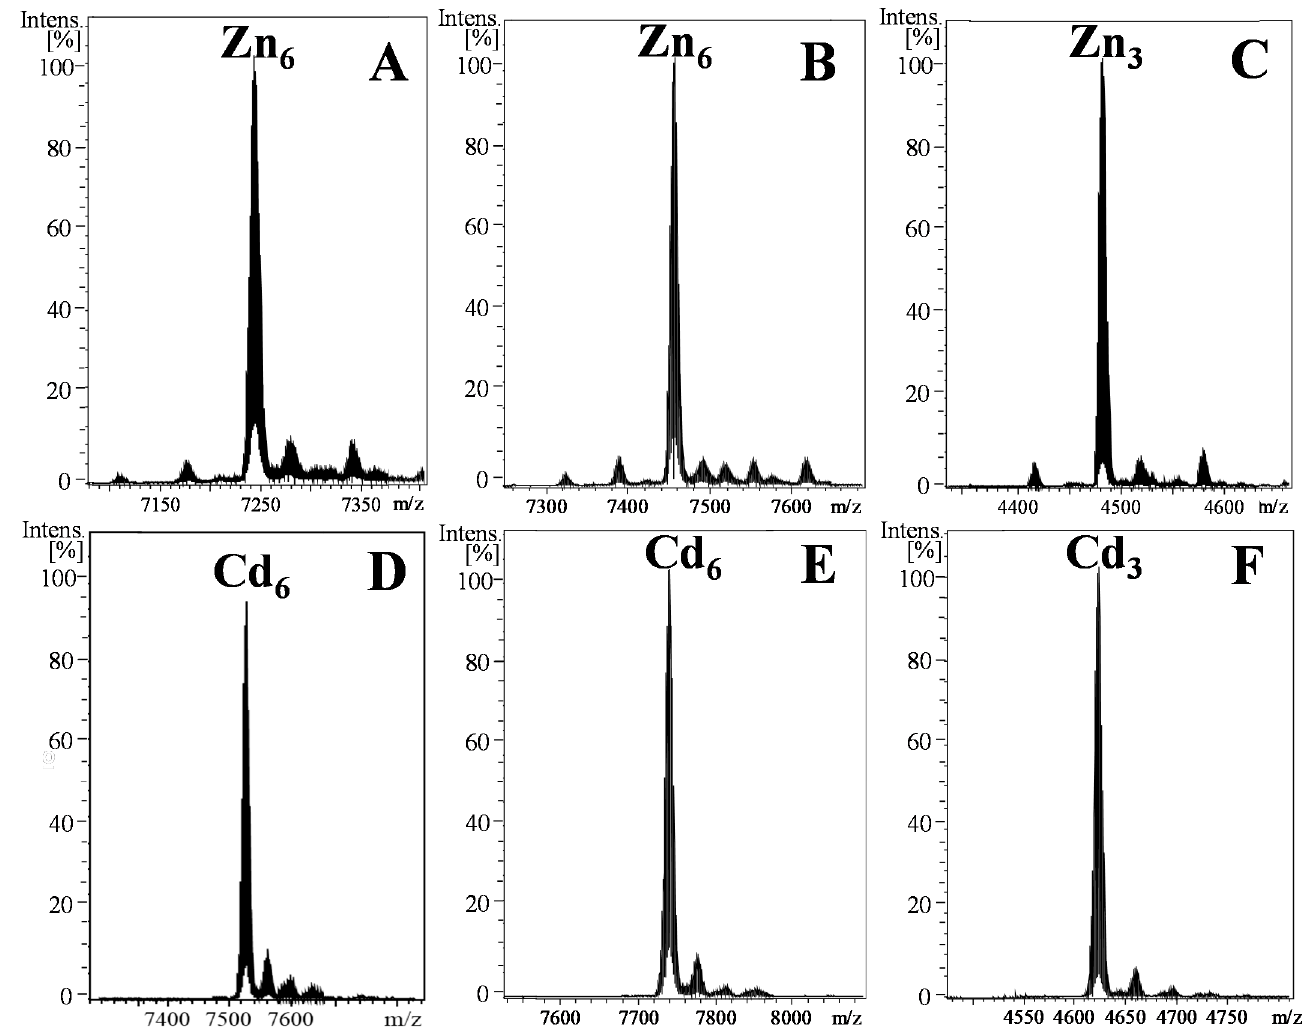
Figure 3. Deconvoluted ESI–MS spectra measured at pH 7.0 of the products obtained from ( A ) NpeMT1, ( B ) NpeMT2, and ( C ) β 3NpeMT2 recombinant synthesis in Zn-enriched E. coli cultures and ( D ) NpeMT1, ( E ) NpeMT2, and ( F ) β 3NpeMT2 recombinant synthesis in Cd-enriched E. coli cultures.